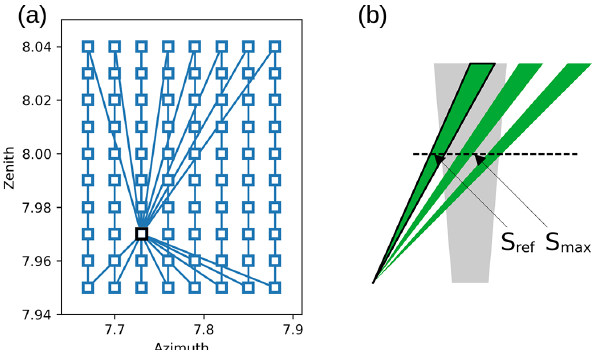
Figure 9. (a) Laser mapping scan geometry, after each zenith scan a measurement in the reference position (black square) is performed. (b) Schematic of the telescope FOV and laser beam for different